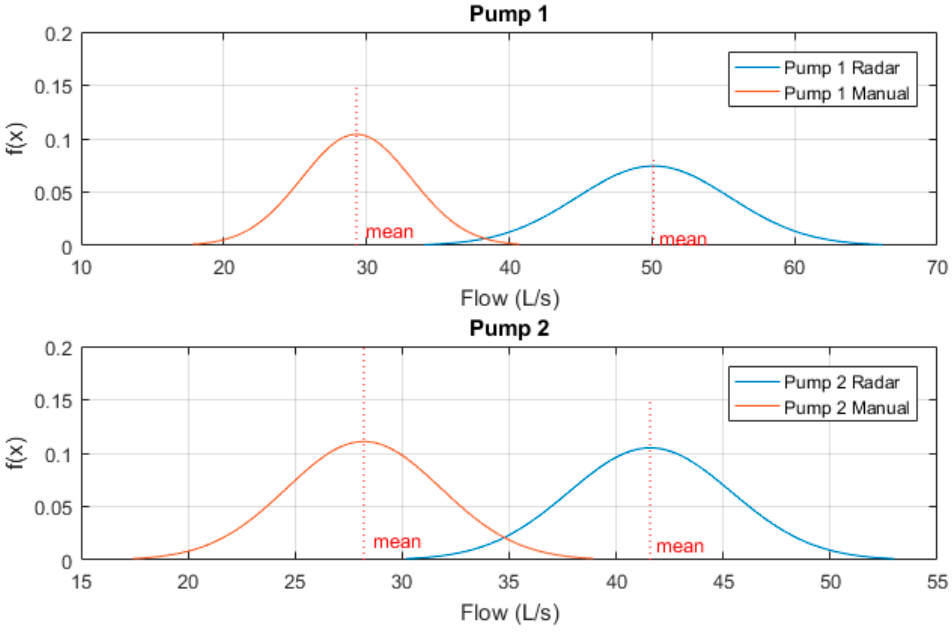
Figure 16. Site C normalised radar vs manual testing results.